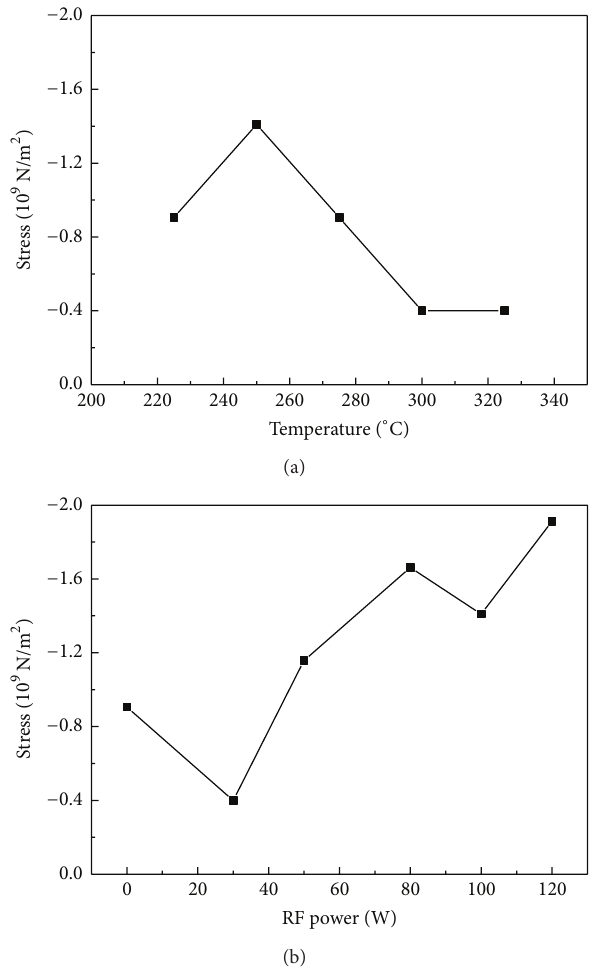
Figure 3: The in-plane stress for the AZO as deposited at 325 ∘ C with (a) various RF power and (b) various substrate temperatures.